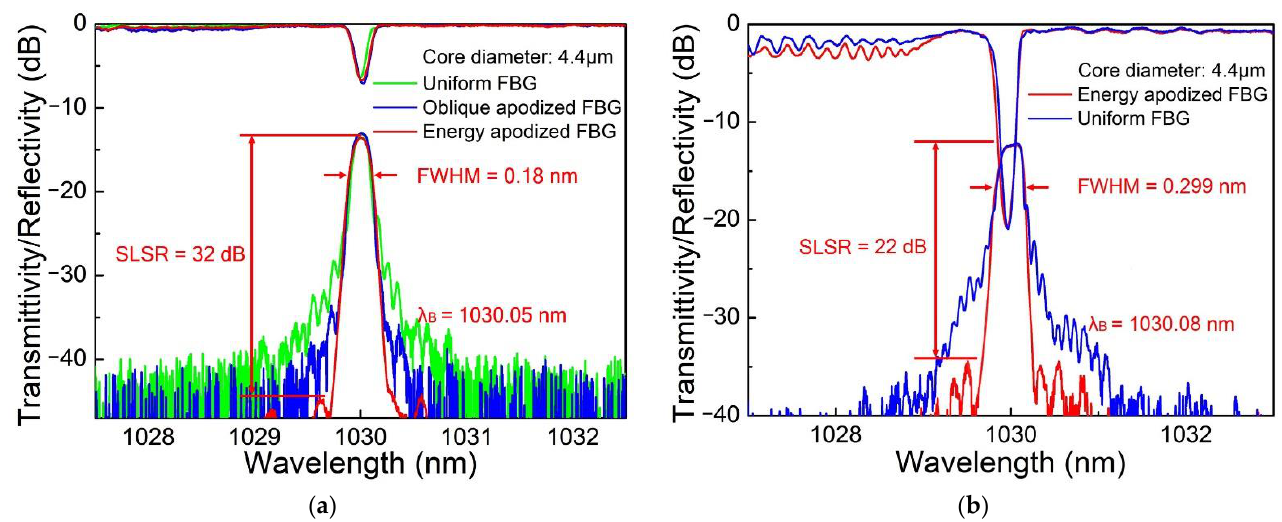
Figure 4. ( a ) Comparison of a uniform FBG spectrum and an apodized FBG spectrum with a reflectivity of 75% fabricated by two methods in fibers with a core diameter of 4.4 μm. ( b ) Comparison of a uniform FBG spectrum and an apodized FBG spectrum with a reflectivity of 99% fabricated by an energy regulation method in fibers with a core diameter of 4.4 μm.